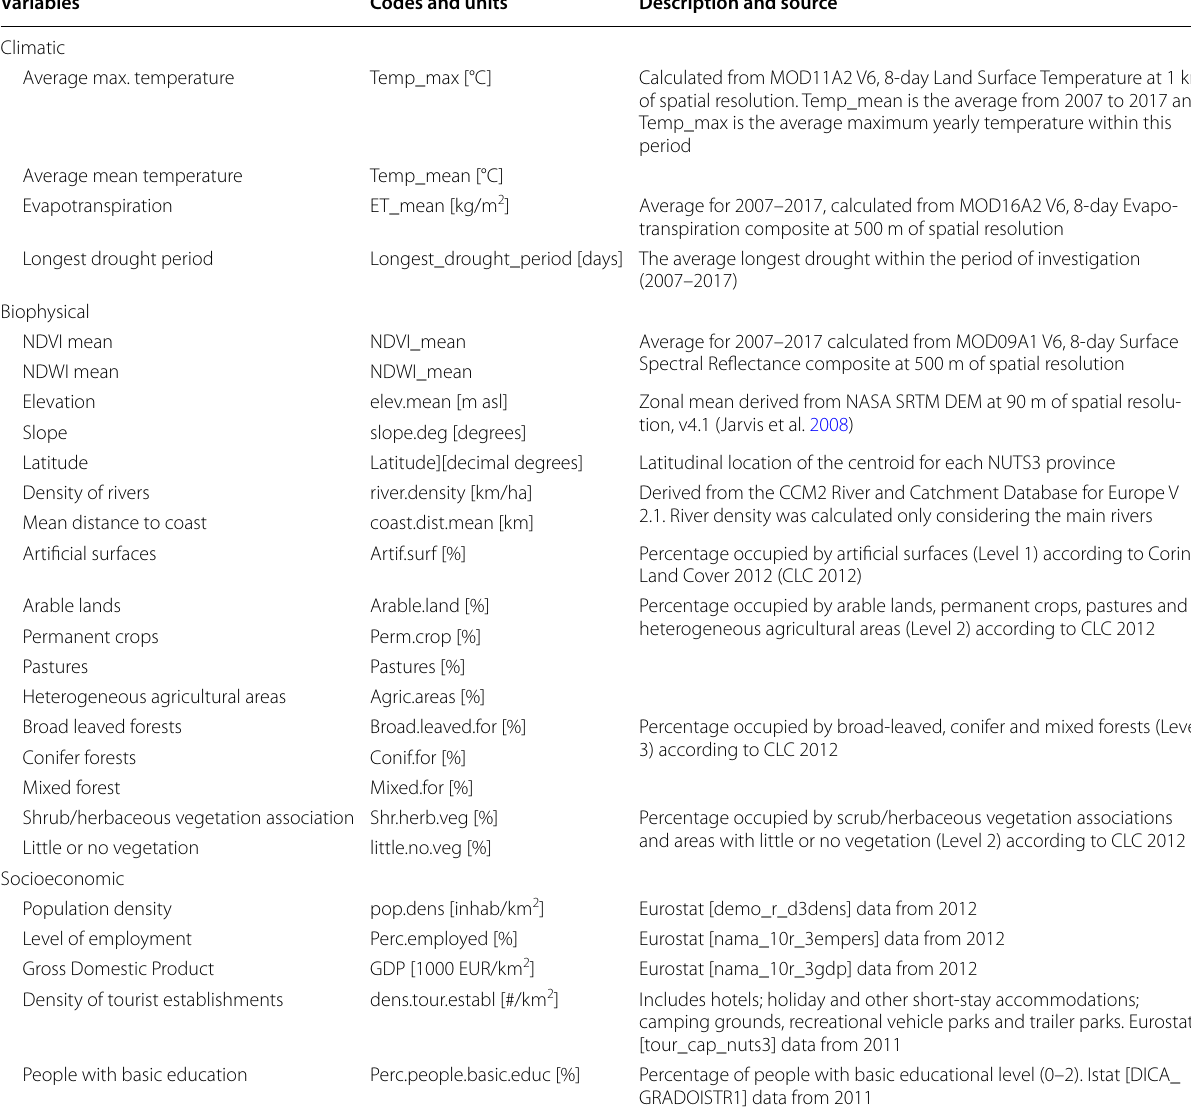
NDVI Normalized Difference Vegetation Index, NDWI Normalized Difference Water Index